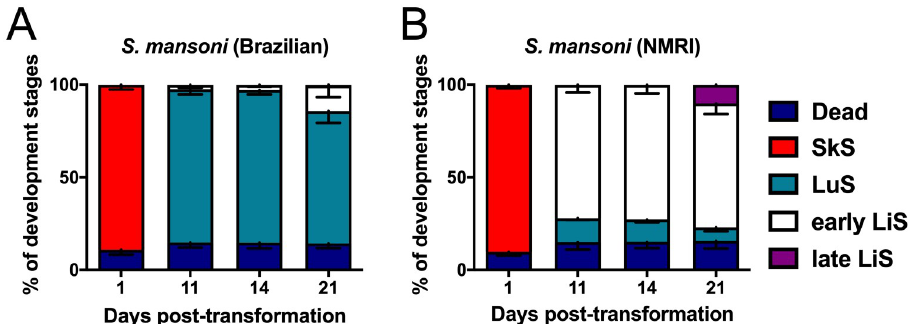
Fig 3. Differences in the development of Schistosoma mansoni strains. Juveniles were cultured in HM supplemented with 200 U/mL penicillin and 200 μ g/mL streptomycin and 20% commercial human serum (S106B-EU). The percentages of the developmental stages, as well as dead parasites, were assessed in culture with (A) S . mansoni Brazilian strain and (B) S . mansoni NMRI strain. Results for the percentages of the developmental stages are based on five replicates per condition per time point. HM: Hybridomed Diff 1000; SkS: Skin stage; LuS: Lung stage; LiS: Liver stage.